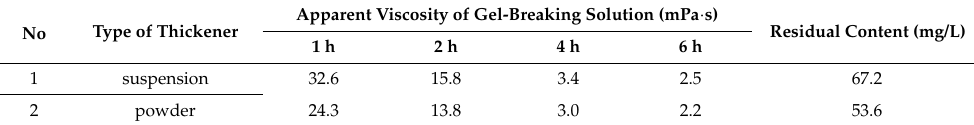
Table 1. Gel-breaking test of suspension diluent and powder